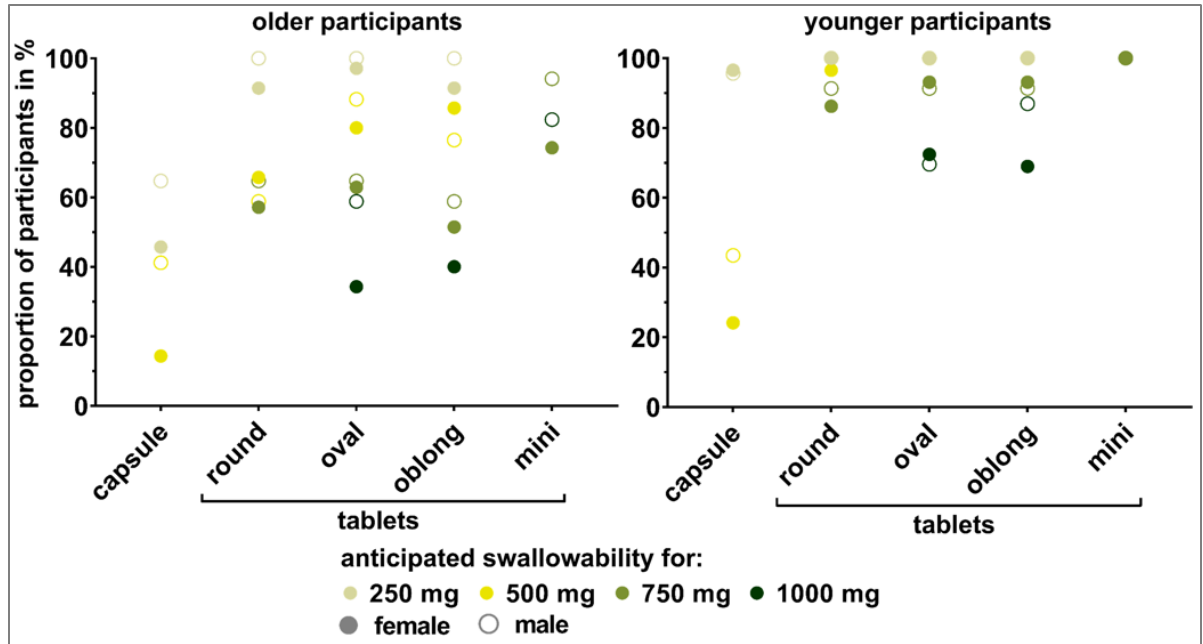
Figure 10. Influence of sex on the visual perception of the swallowability of the dosage forms pre- sented within weight-showcases. Data are shown separately for older participants (67.3% female; left panel) and for younger participants (55.8% female; right panel).